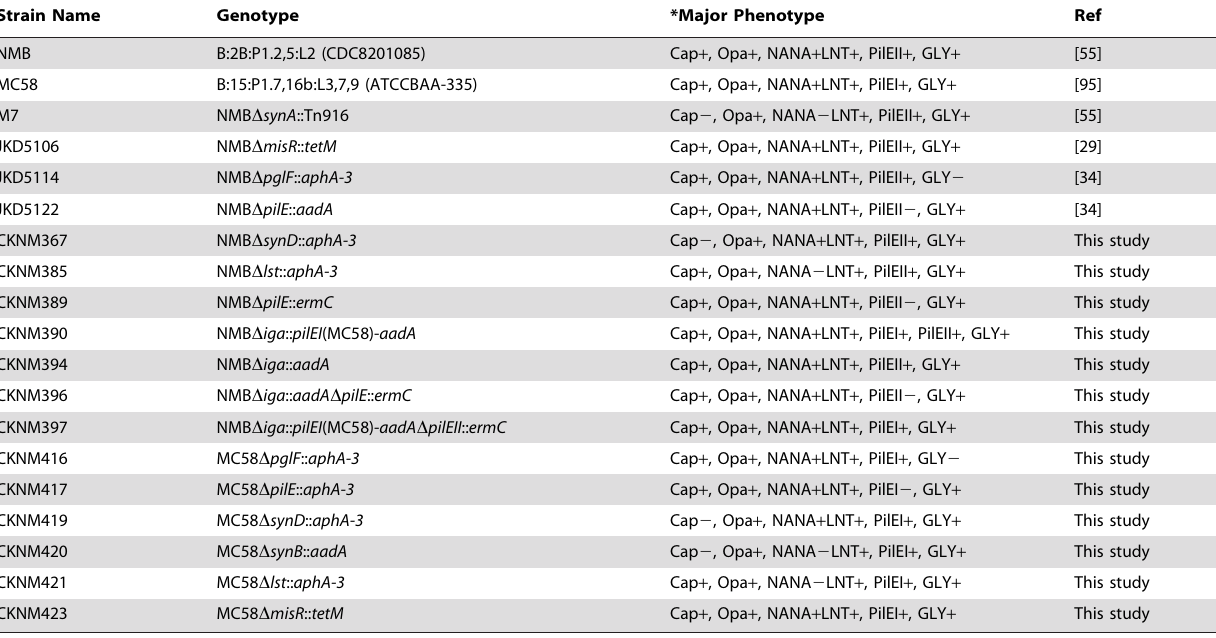
Table 1. Strains used in this